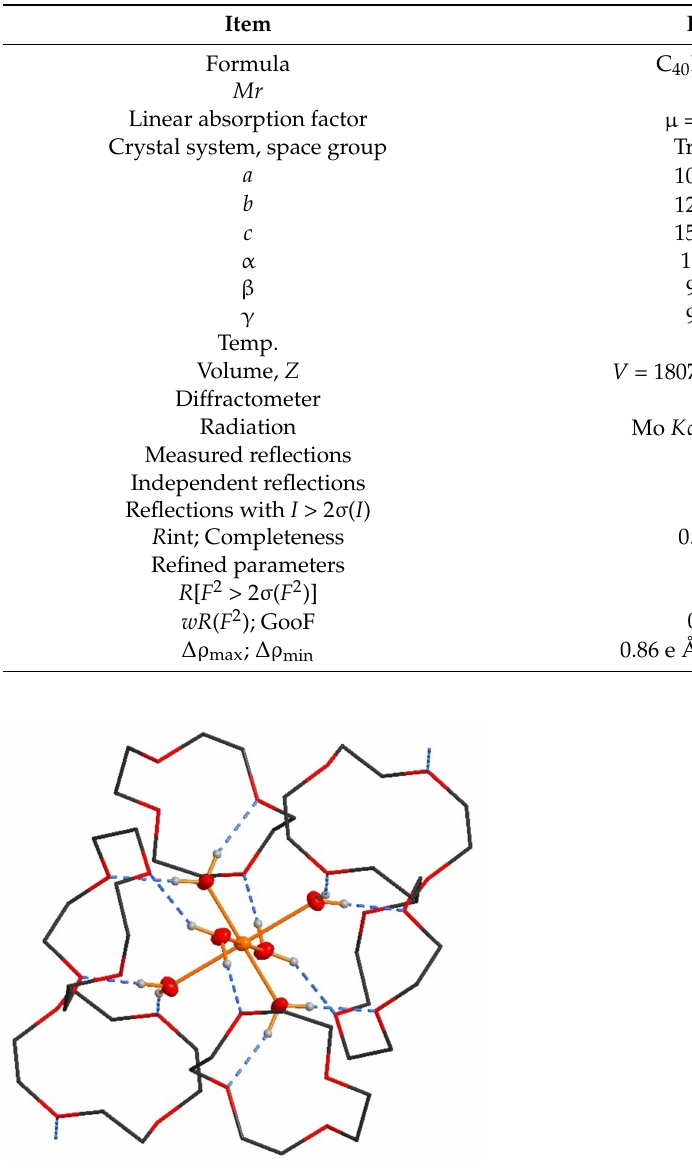
Figure 3. [Cu(12-crown-4) 5 (H 2 O) 6 ]I 6 · 2I 2 . Hexaaquacopper(II) complex surrounded by six 12-crown- 4 molecules. The non-hydrogen atoms of the hexaaquacopper(II) complex are shown as ellipsoids with a probability of 50%. The 12-crown-4 molecules are shown in wireframe